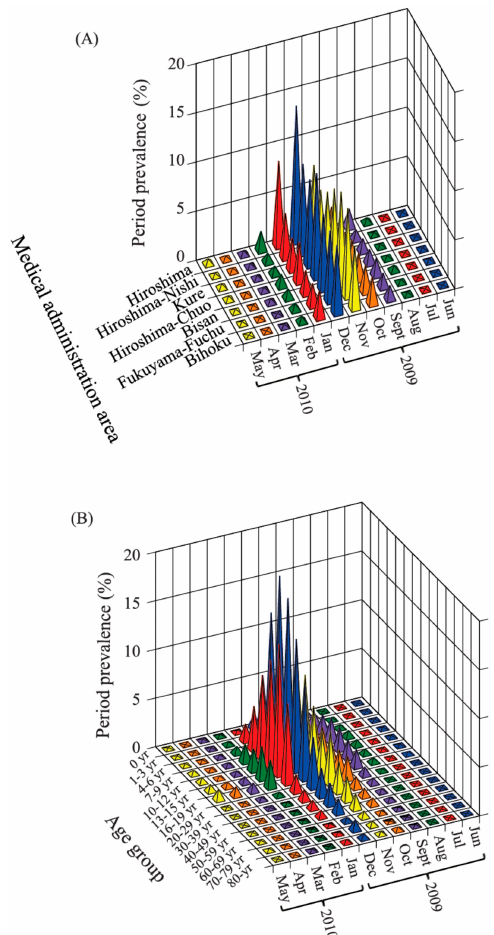
Figure 2. Period prevalence (%) from June 2009 to May 2010. Period prevalence is shown by: area ( A ); and age ( B ). 3.4. Overall Cumulative Incidence of Influenza, OR of Cumulative Incidence and VE Based on Vaccination Status A total of 169,105 responses were available to estimate Influenza vaccine effectiveness and its cumulative incidence, 122,529 for the participants aged 0–15 years, and 46,576 for those aged 16 and